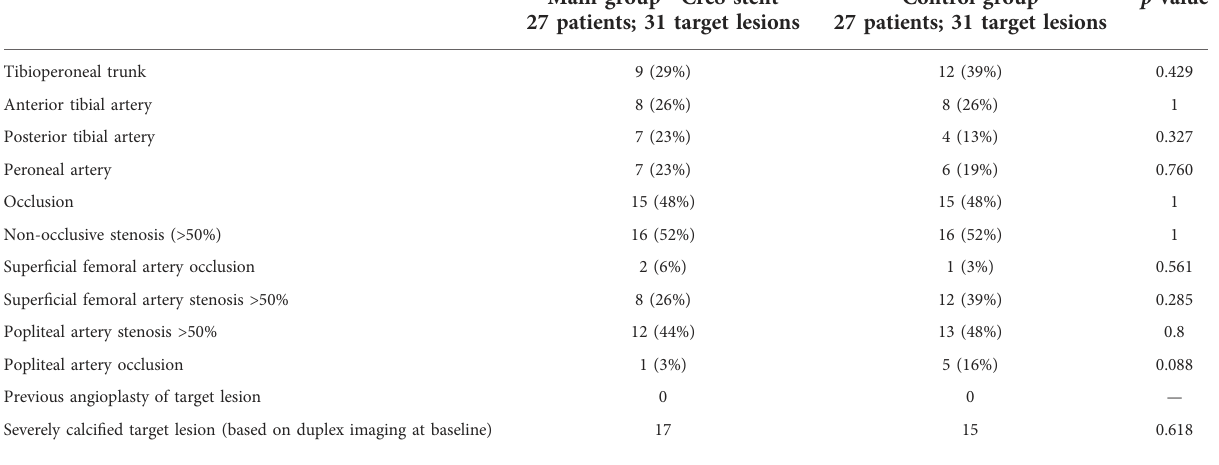
TABLE 2 Target lesion characteristics per